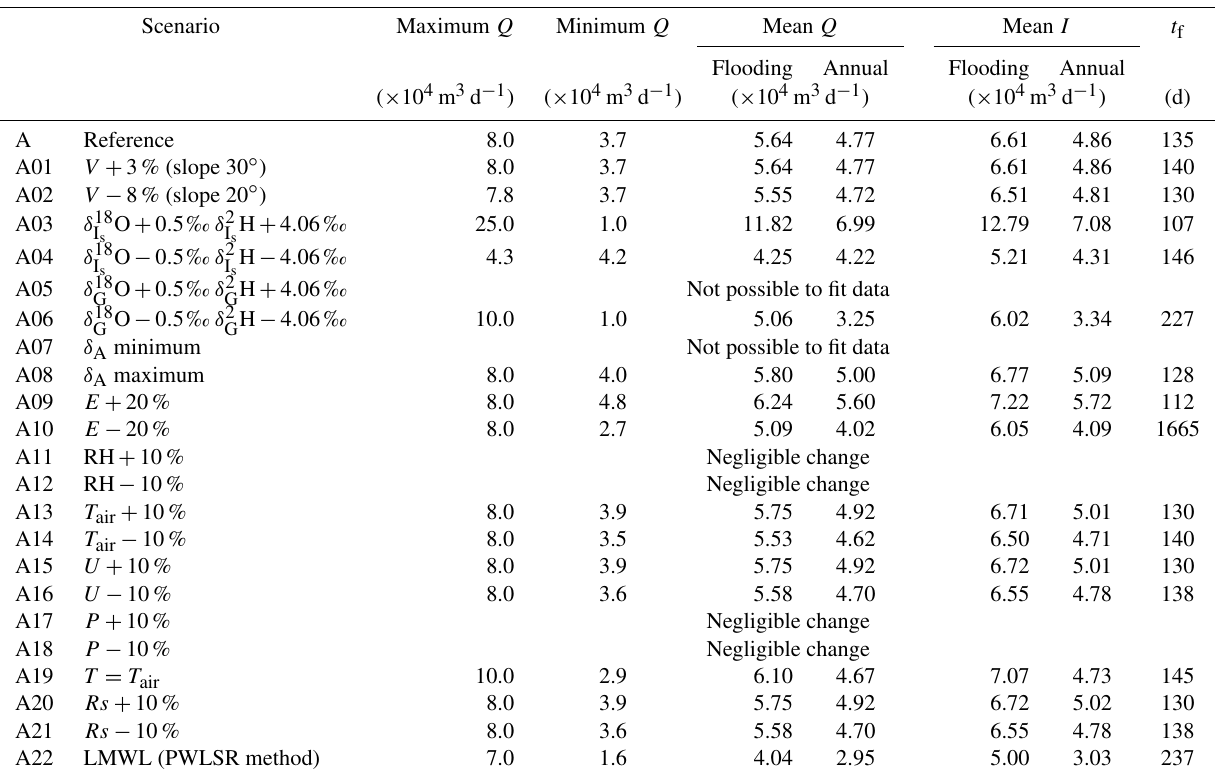
Table F1. Sensitivity analysis on the input parameters of the isotopic mass balance model. Q is the output flux from lake A, I the input flux, and t f the mean flushing time by